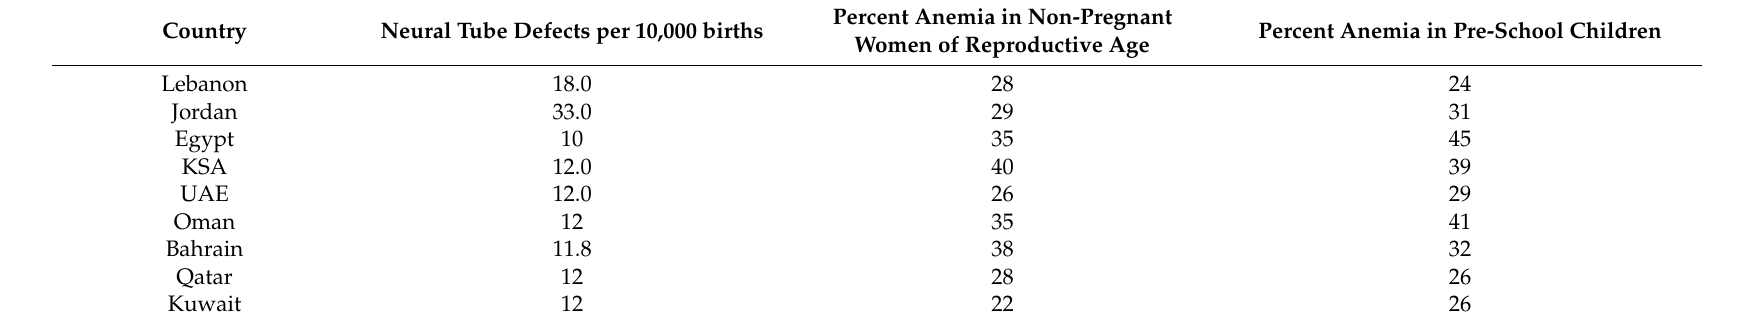
Table 3. Neural tube defects and anemia status in selected countries of the Middle East a,b